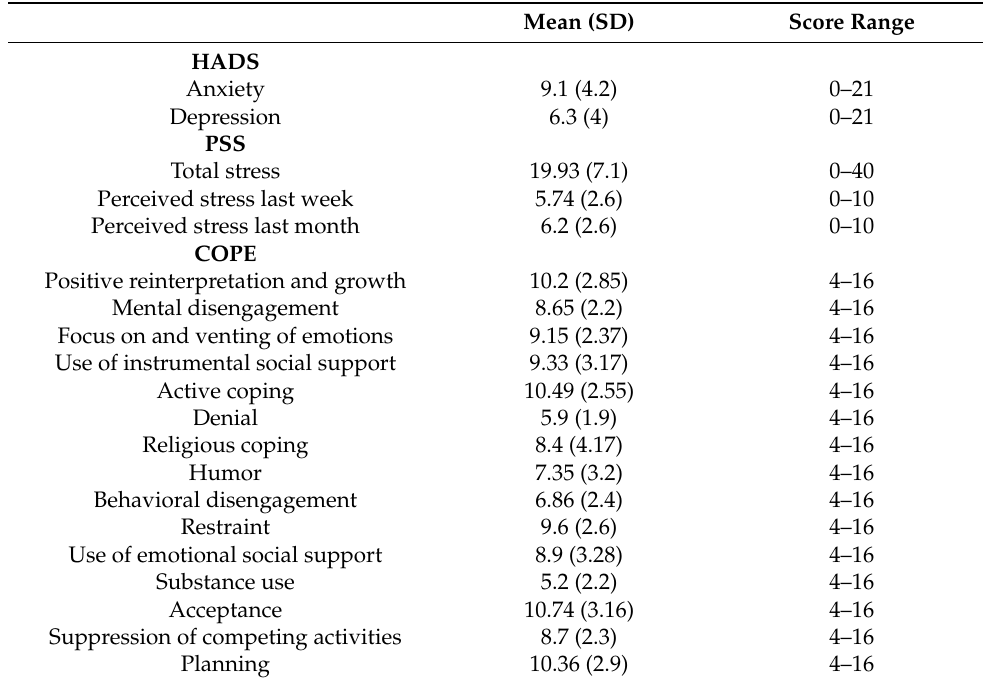
Table 3. Comparison between TAS-20 results in MD subjects and normative data by t -test expressed as mean and standard deviation between parentheses.